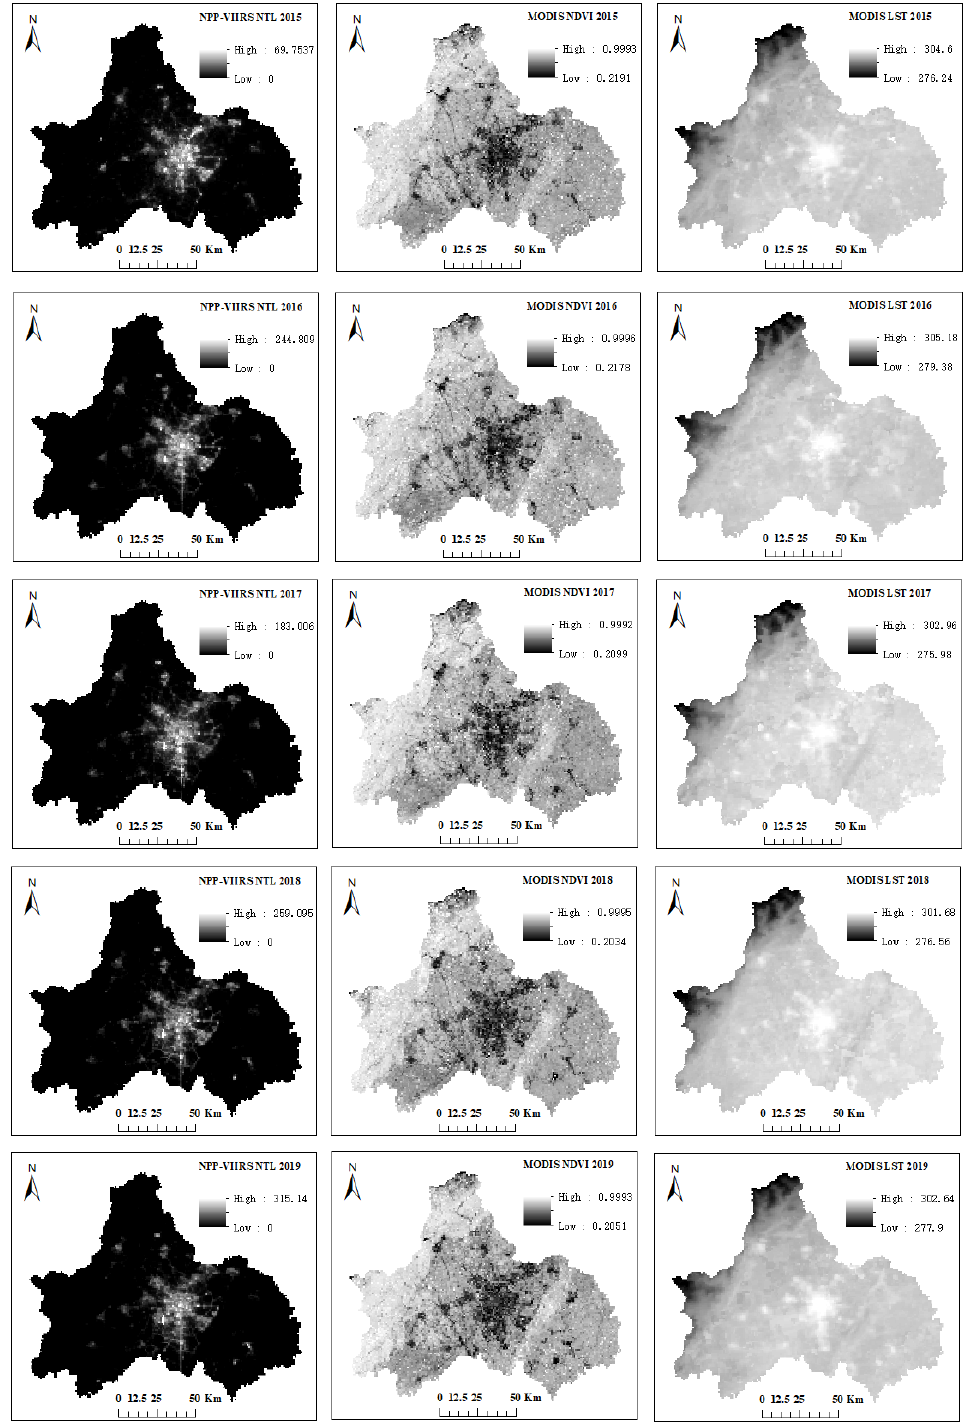
Figure 2. The data of three main data sources in Chengdu from 2015 to